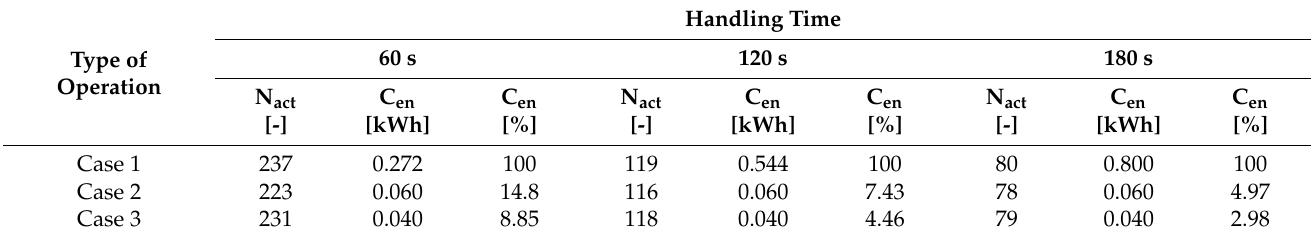
Table 1. A resumption of comparisons between the three cases: the number of activations during one working day (8 h), as well as the energy consumption for 1 activation in [kWh] and [%].